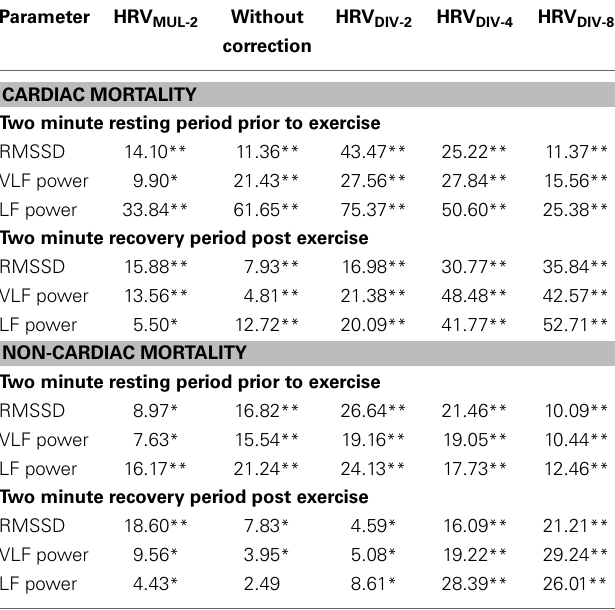
Table 3 | Chi-square values for Kaplan-Meier analyses under different heart rate correction methods for cardiac and non-cardiac